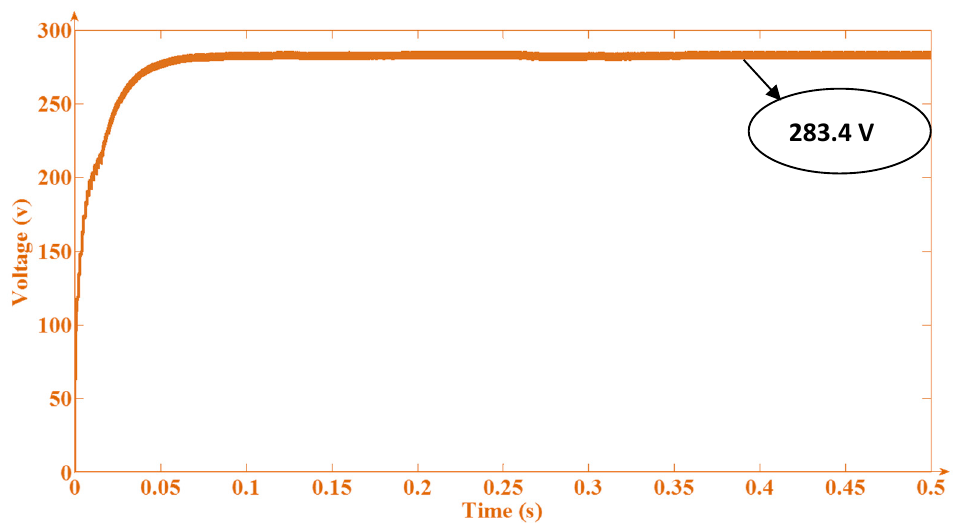
Figure 40. Output voltage waveform for fuzzy-based BDC.